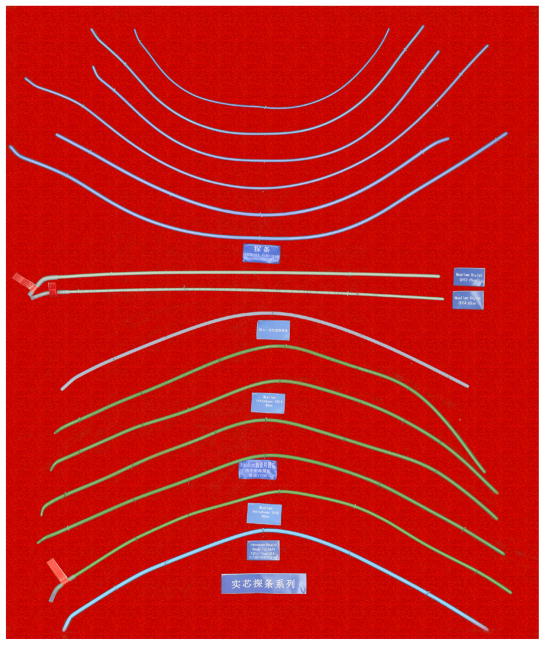
Traditional stylets.